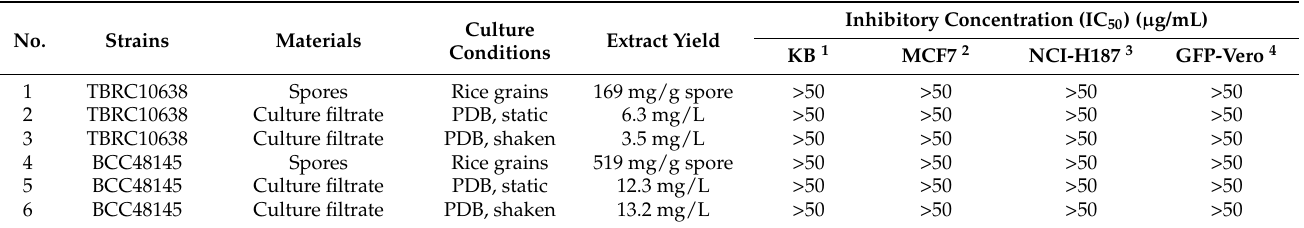
Table 2. Cytotoxicity test of the extracts from P. lilacinum TBRC10638 and B. bassiana BCC48145 against 4 animal cell